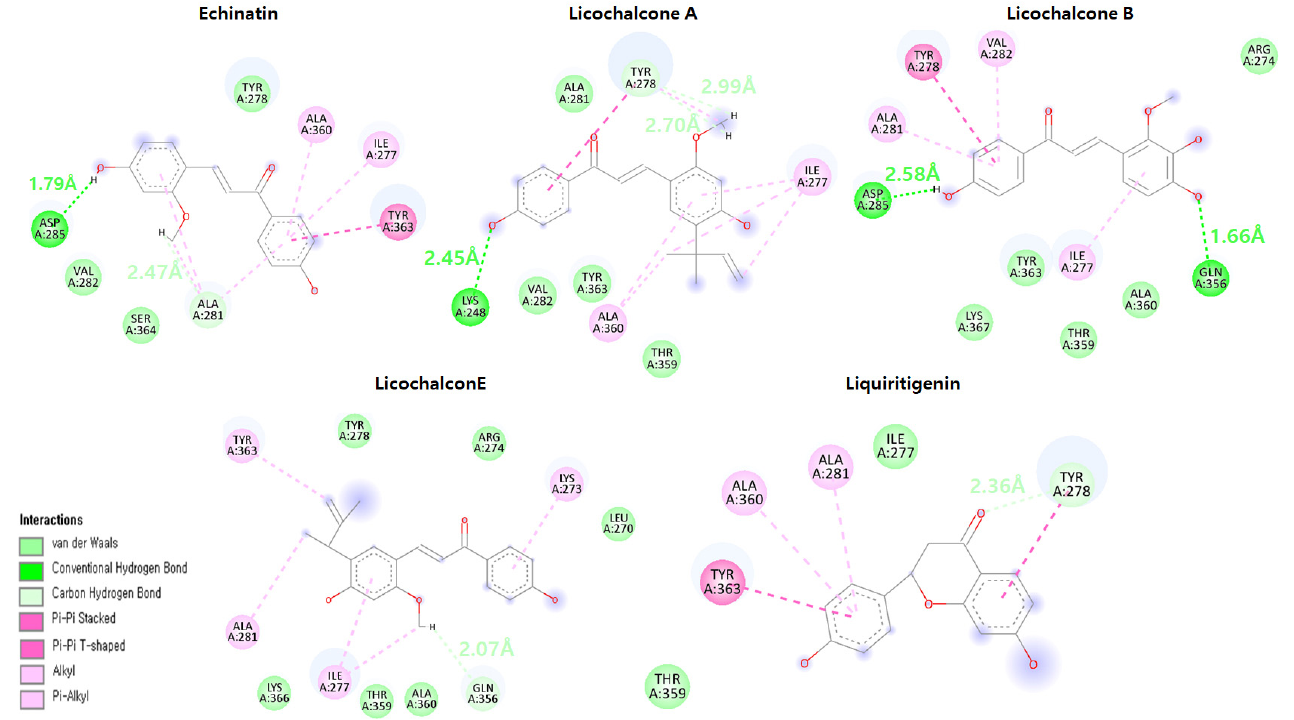
Figure 11. The figure depicts the interaction of licorice compounds in the active region of DBP. The conventional hydrogen bonds are predicted in green color, while carbon hydrogen bonds are depicted in light green color, and the hydrogen bonding distances are mentioned with respective colors.